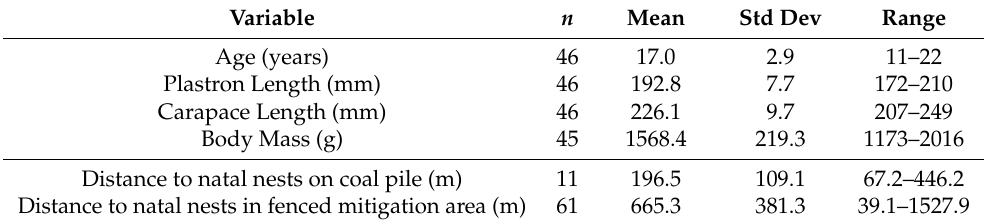
Table 1. Characteristics at first recapture of reproductive female Northern Map Turtles marked as hatchlings that recently returned to Mount Union, Pennsylvania, as well as distances between recent recapture locations and their natal